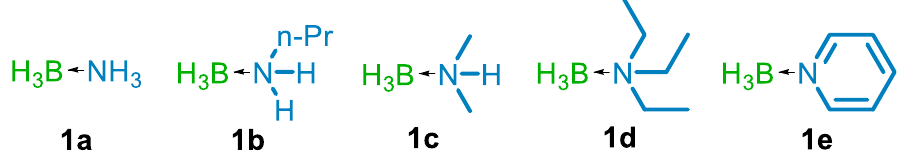
Figure 1. Amine-boranes examined for the reduction of organonitriles. Molecules 2023 , 28 , x FOR PEER REVIEW 4 of 11 Having optimized the reaction conditions to achieve the reduction of benzonitrile in 95% yield, the scope of the methodology was studied with respect to the organoni- trile partner (Figure 2). Initially, the effect of substitutions on the benzene ring at the ortho- , meta -, and para -positions was evaluated. Thus, ortho -chlorobenzonitrile ( 2b ), meta -fluorobenzonitrile ( 2c ), and para -fluoro-( 2d ), -chloro-( 2e ), and -bromo-( 2f ) benzonitriles were converted to the corresponding amines ( 3b – 3f ) in 70–72% yields, respectively. Ad- ditionally, 2,4-difluorobenzonitrile ( 2g ) provided the desired benzylamine product 3g in 77% yield. No dehalogenation product was observed in all these cases.